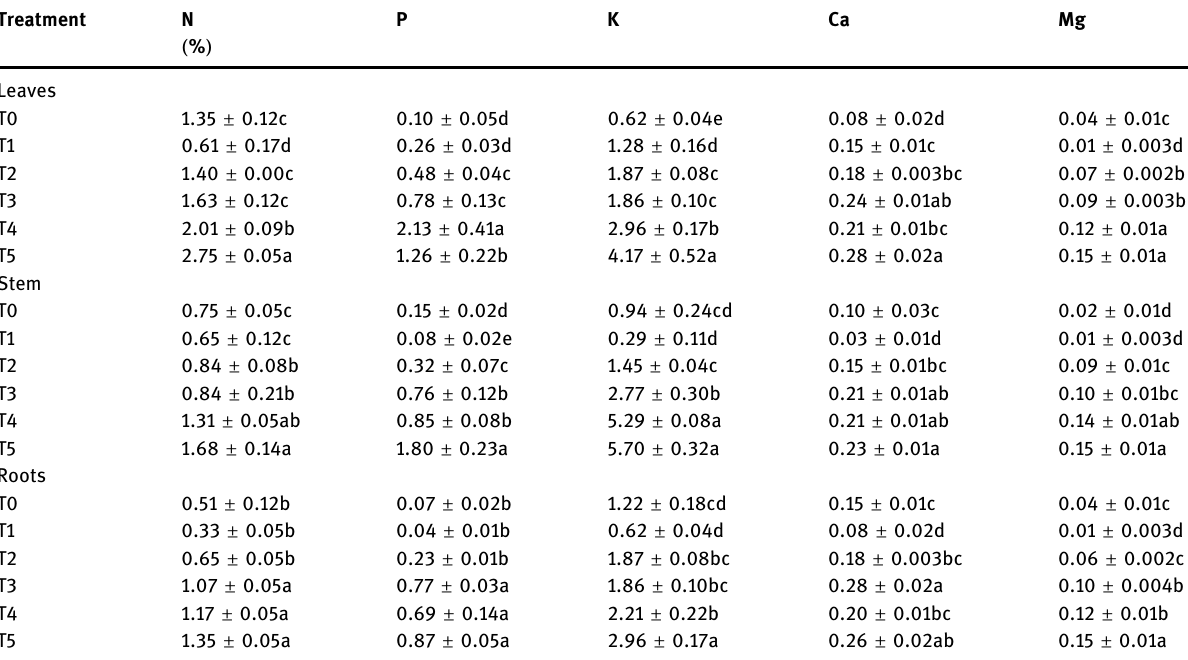
Table 7: E ff ects of amending CIRP with RS compost on plant nutrients concentrations of Zea mays L. F1 hybrid sweet corn 801 variety at 60 DAS of pot experiment